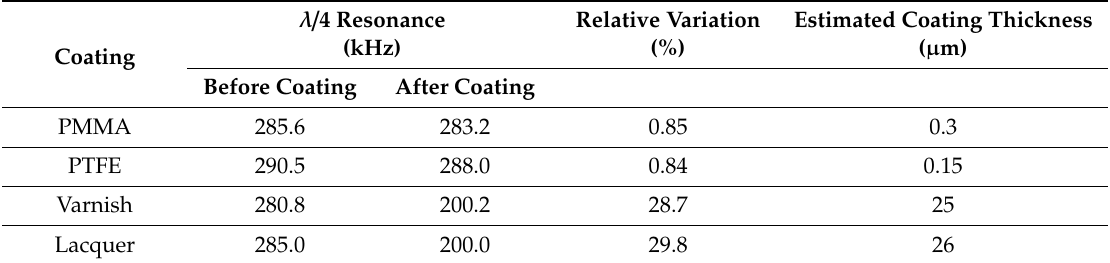
Table 3. Frequency shift due to the coting and estimated coating thickness.